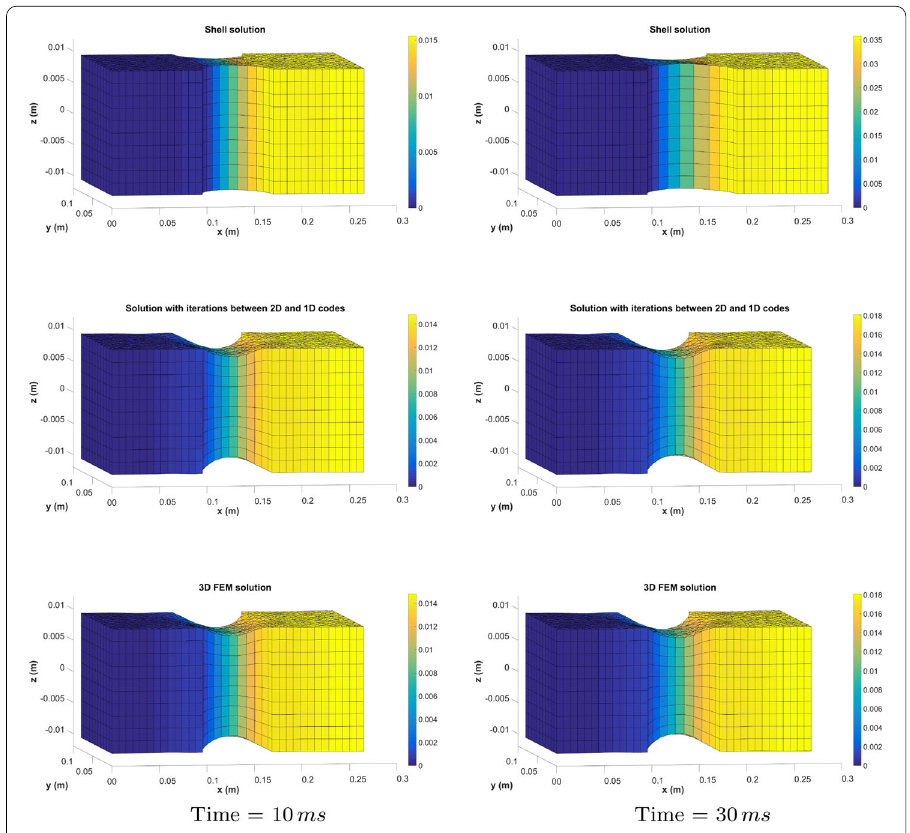
Fig. 16 Displacement field using the three methods for t = 10 ms and t = 30